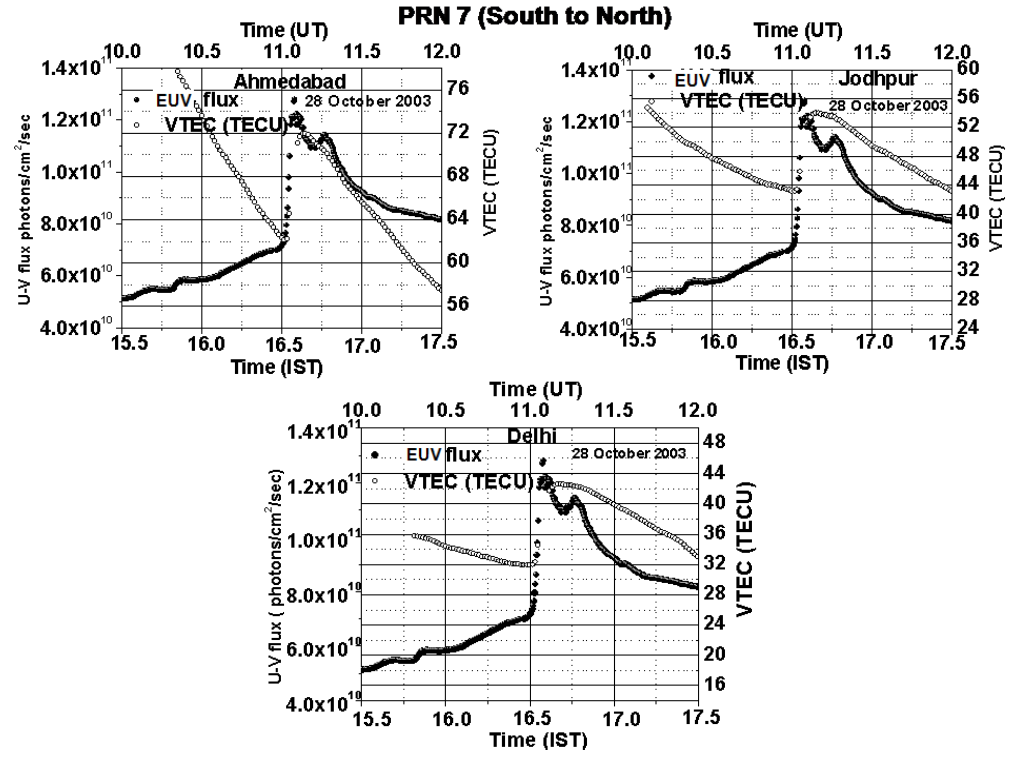
Fig. 5. The time variations of VTEC (around the time of the flare) as seen by the same satellite from three stations of Ahmedabad (top left panel), Jodhpur (top right panel) and Delhi (bottom